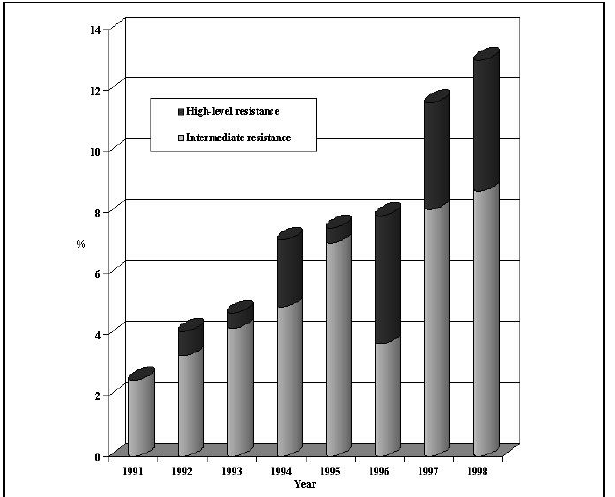
Figure 1) Rates of reduced penicillin susceptibility among pneumo- coccal isolates from Canadian Paediatric Society/Laboratory Centre for Disease Control Immunization Monitoring Program, Active (IMPACT) centres, 1991 to 1998